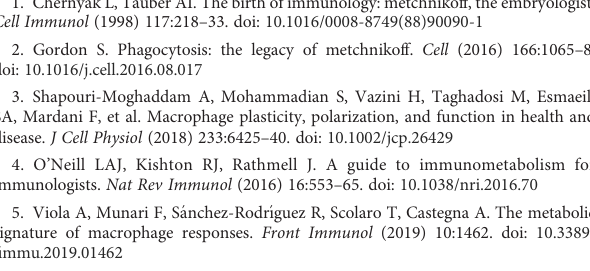
SUPPLEMENTARY FIGURE 1 Morphology of prepared macrophage. Bone marrow-derived